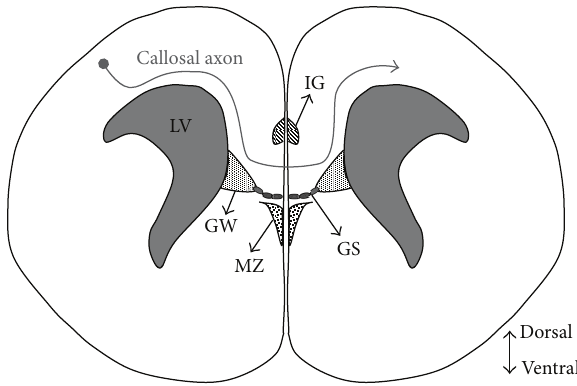
Figure 1: Glial populations around the midline. The locations of the midline glial populations on a coronal section of the E15.0 mouse brain are shown. These populations are mainly composed of four structures: the glial wedge (GW), the indusium griseum (IG), the midline zipper (MZ), and the glial sling (GS). These populations guide the growth of the callosal axons and help them cross the midline in the CC. LV: lateral